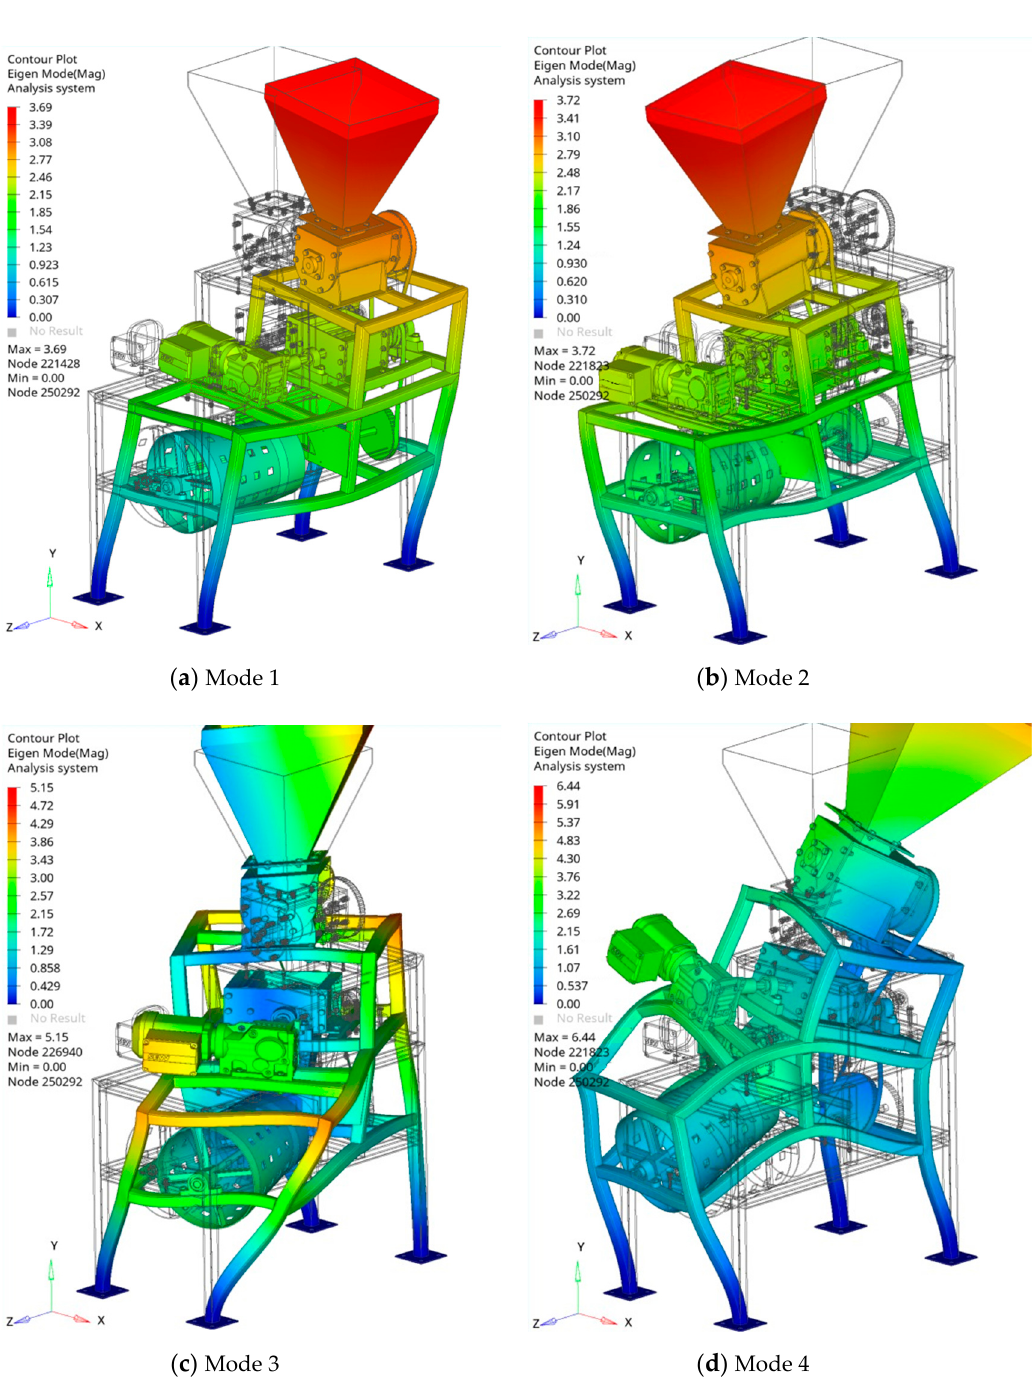
Figure 23. Principalmodalshapesofvibration; ( a )First; ( b )Second; ( c )Thirdand( d